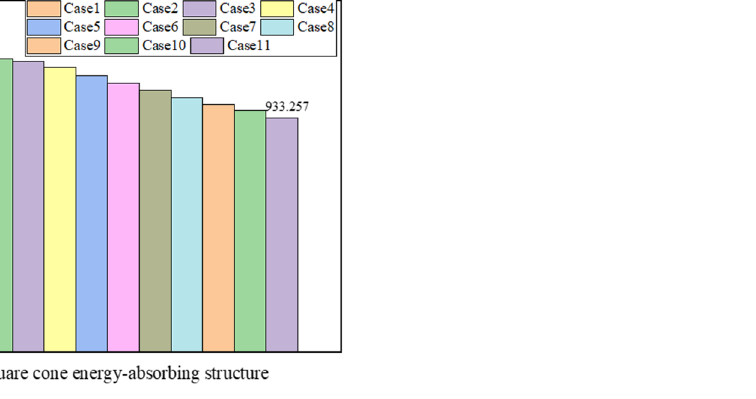
Figure 17. Influence of the slope of platform force change on specific impact interfaces: ( a ) the head cars: M0 and S0; ( b ) the first middle car interfaces; ( c ) the second middle car interfaces; ( d ) the third middle car interfaces.